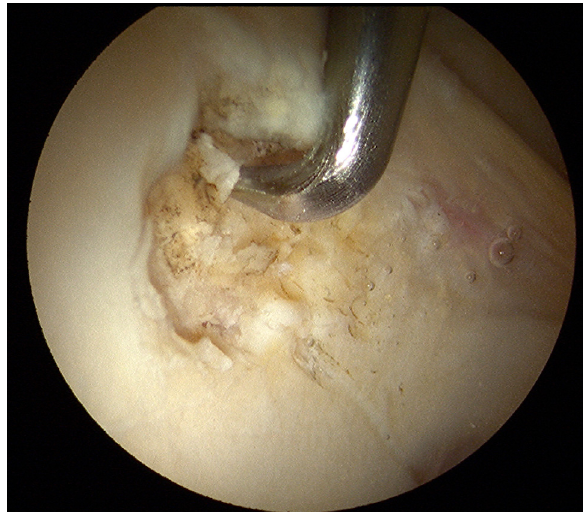
Figure 4. Cartilage lesion ALAD 4 treated with debridement and stabilization of the borders together with microfracturing.